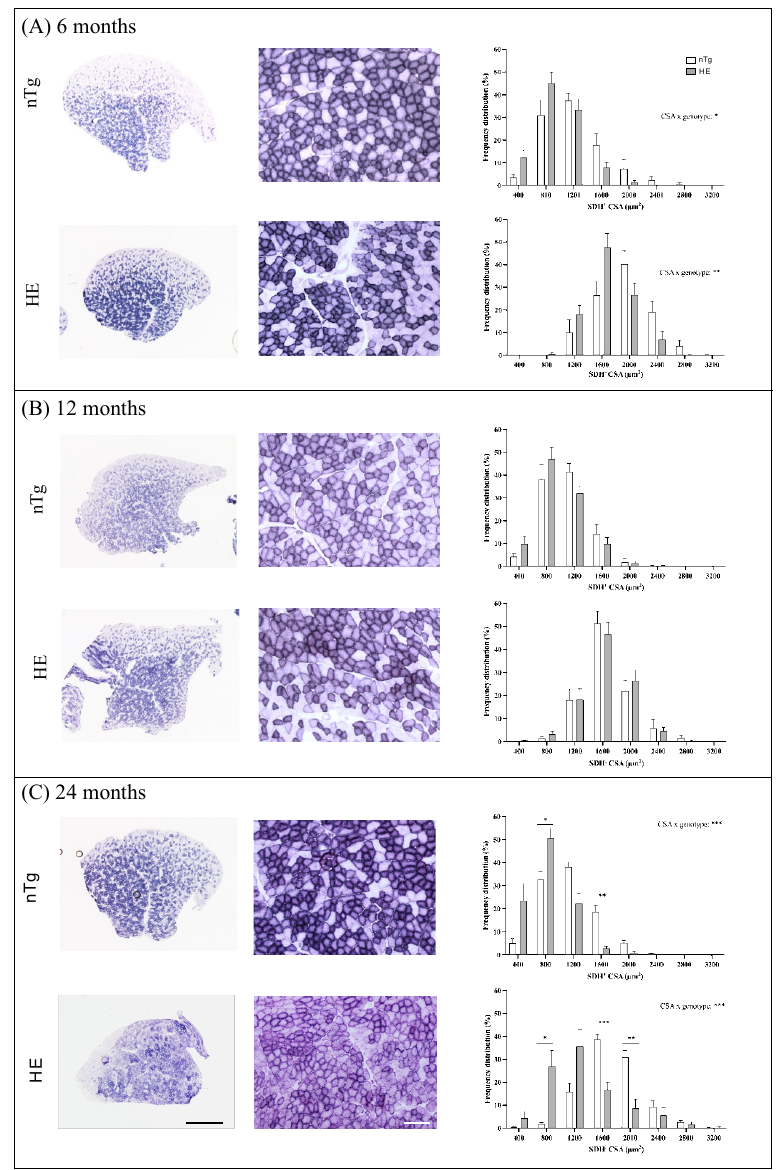
Figure 7. Histochemical detection of SDH activity in TA of nTg and HE mice at 6 ( A ), 12 ( B ), and 18–24 ( C ) months of age. Left: Representative low magnification micrographs showing the global SDH staining in TA. Scale bar: 500 µm. Middle: Representative high magnification micrographs showing the variety of SDH staining within the TA. Scale bar: 50 µm. Right: cross-sectional area (CSA) of SDH + and SDH − fibers were measured and the distribution of the fiber CSA is presented. Note the shift to the left at 6 and 14 months of age for HE compared to nTg mice. Histograms represent means ± SEM, n = 5–10 mice/genotype and 100 SDH + and 100 SDH − fibers were analyzed/mice. Two ways ANOVA followed by Tukey’s post hoc test. * p < 0.05, ** p < 0.01, and *** p < 0.001.